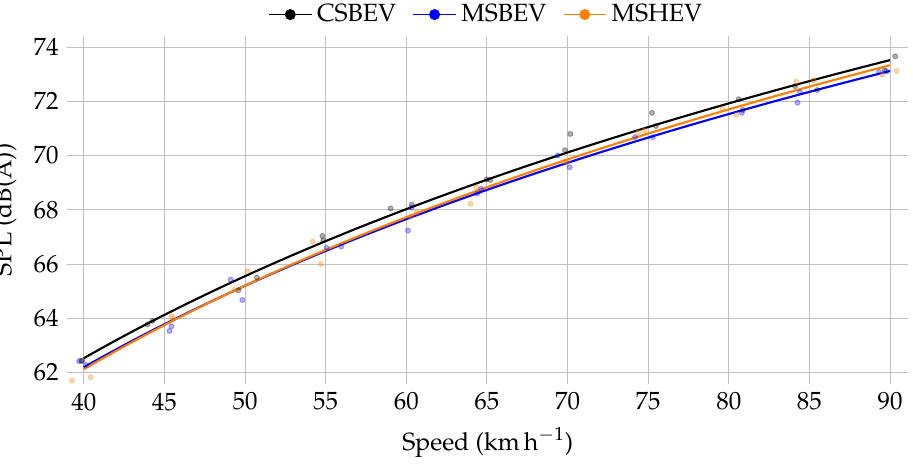
Figure 11. Air temperature corrected rolling SPL regression curves compared on three different vehicles for 255H on the left